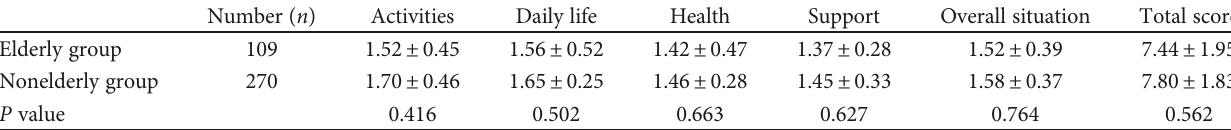
Table 4: The QL-Index scores between elderly and nonelderly groups.